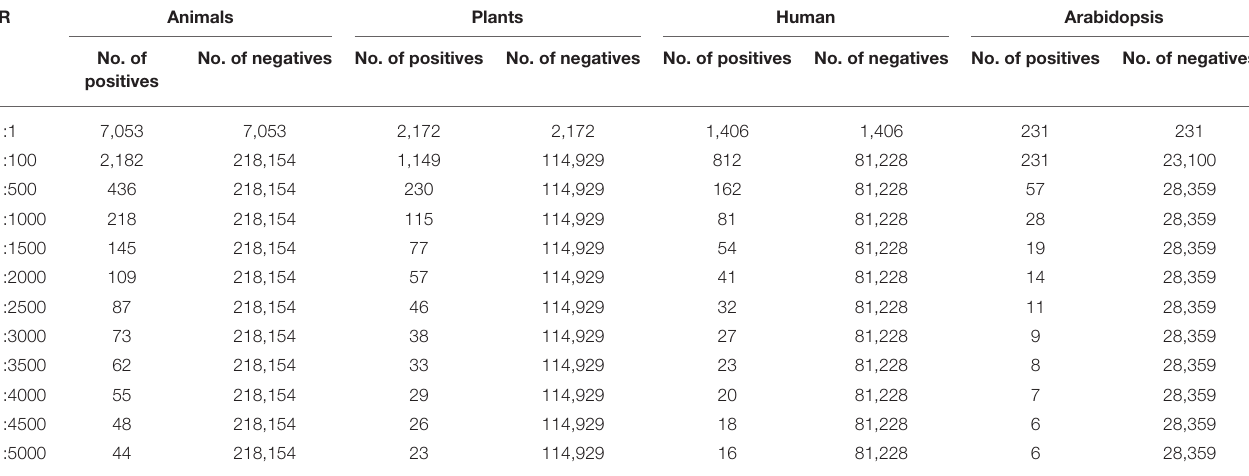
TABLE 2 | The no. of positive and negative samples for different Imbalance Ratios. IR Animals Plants Human Arabidopsis